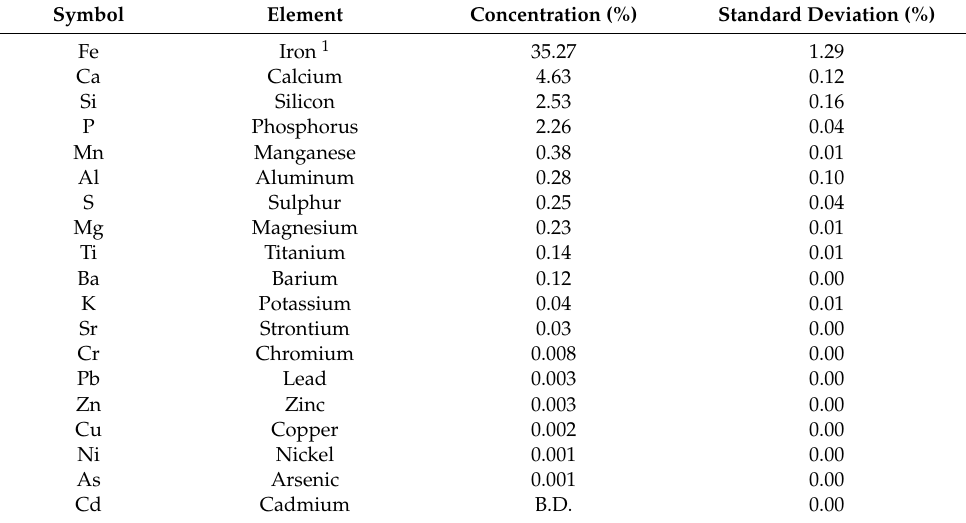
Table 1. The major constituents of ochre. In total, 48 elements were detected.